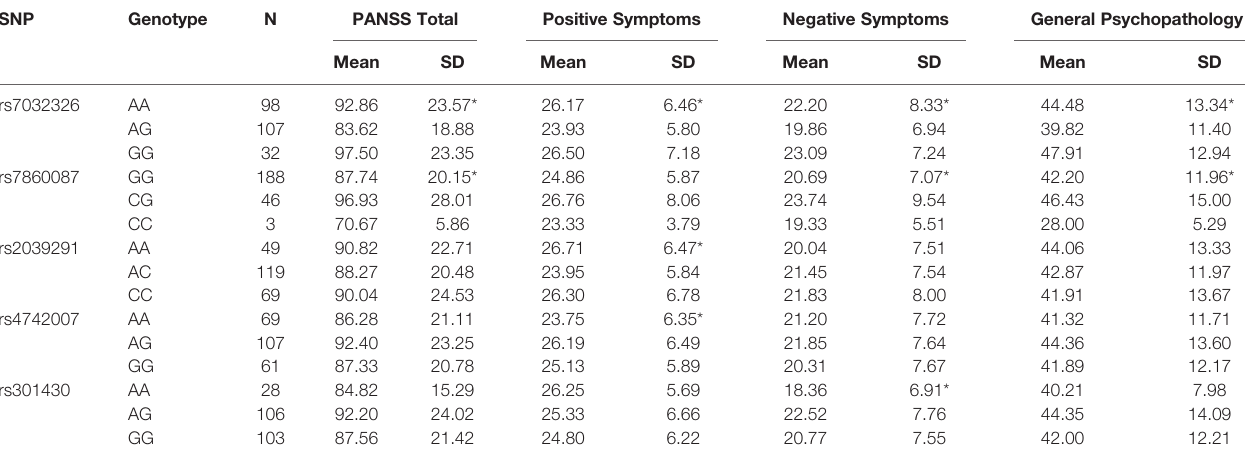
TABLE 4 | Association analyses between SNPs and sub-scores of PANSS in SZ patients. SNP Genotype N PANSS Total Positive Symptoms Negative Symptoms General Psychopathology Mean SD Mean SD Mean SD Mean SD